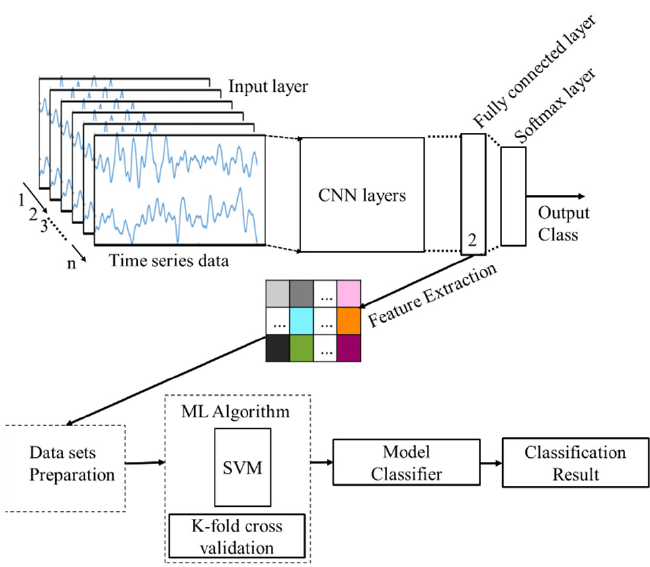
Figure 8. The block diagram of ML + DL approach using CNN + SVM for cognitive load classifica- tion.